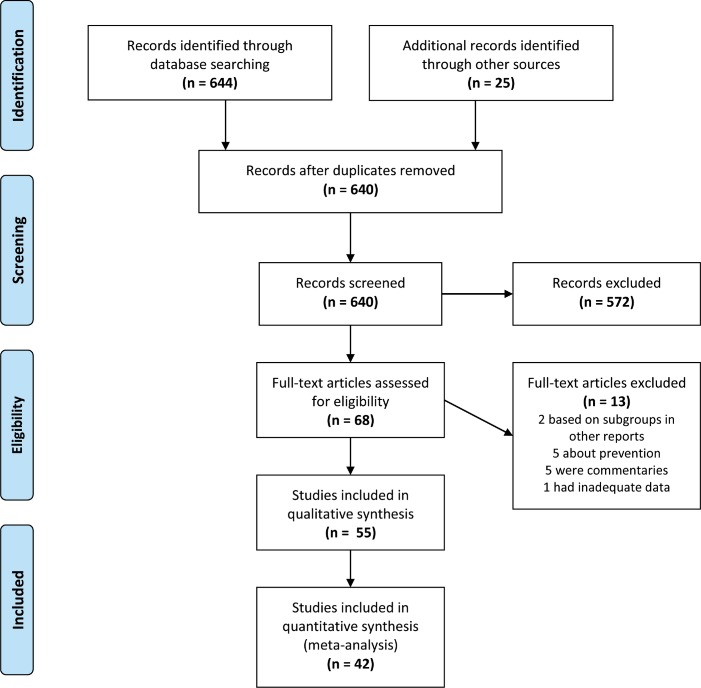
Prisma flow diagram.